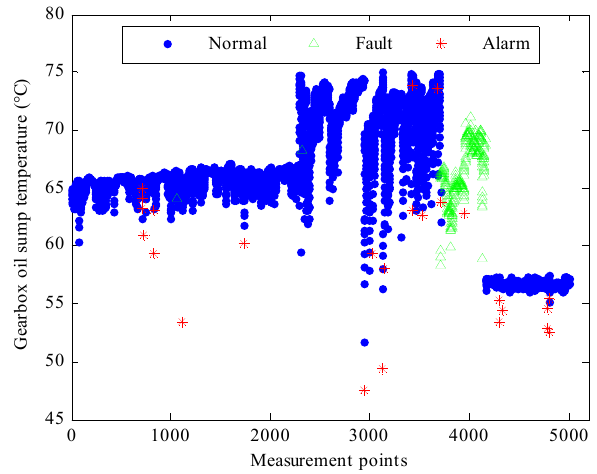
Figure 9. Gearbox oil sump temperature for fault detection.